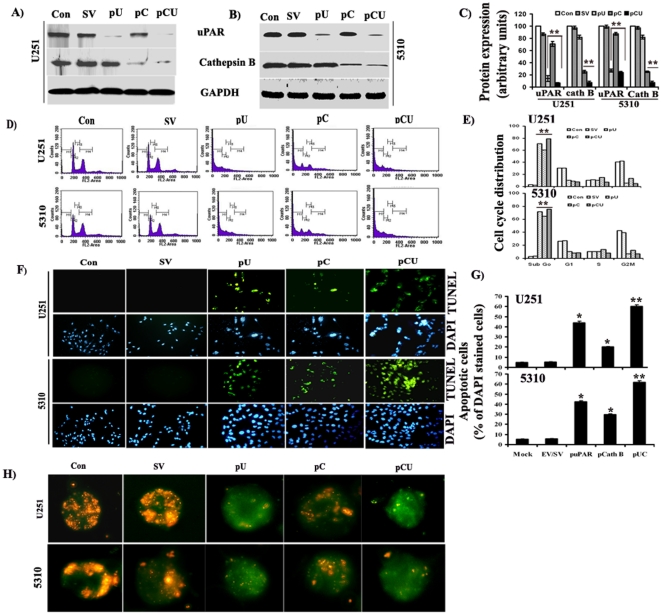
RNAi-mediated depletion of cathepsin B and uPAR induces mitochondrial apoptosis in U251 and 5310 cells.(A–B) Western blot analysis of uPAR and cathepsin B expression in U251 and 5310 cells 72 hrs after transfection with SV, pU, pC and pCU. (C) Quantitative analysis of uPAR and cathepsin B expression by densitometry. Results from three independent experiments are shown as mean ± SD (**p<0.001). GAPDH was used as a loading control. (D) Cell cycle distribution of U251 and 5310 cells. Propidium iodide-stained cells were analyzed for DNA content using flow cytometry. (E) Histograms represent the percentage of cells in G0/G1, S and G2/M phases. The data represent one of three independent experiments. Values are mean ± SD of three different experiments (**p<0.001). (F) Cells were stained for apoptosis using TdT-mediated dUTP nick end-labeling (TUNEL) assay. Data shown are from a representative experiment. (G) Quantification of apoptotic cells expressed as percent of DAPI-stained cells. Bars represent the mean ± SD of three experiments (*p<0.05; **p<0.001). (H) Analysis of mitochondrial membrane potential using MitoLight kit. Cells were collected, incubated with MitoLight dye for 20 min at room temperature, and observed for fluorescence; red fluorescence indicates healthy cells while green fluorescence indicates apoptotic cells.